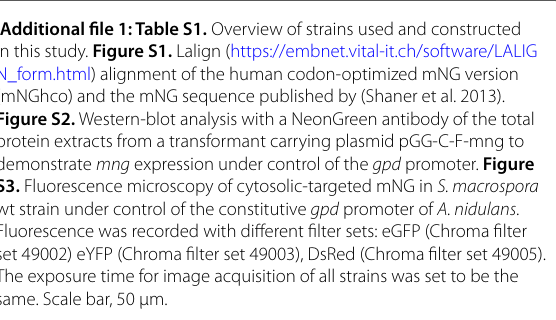
Figure S2. Western-blot analysis with a NeonGreen antibody of the total protein extracts from a transformant carrying plasmid pGG-C-F-mng to